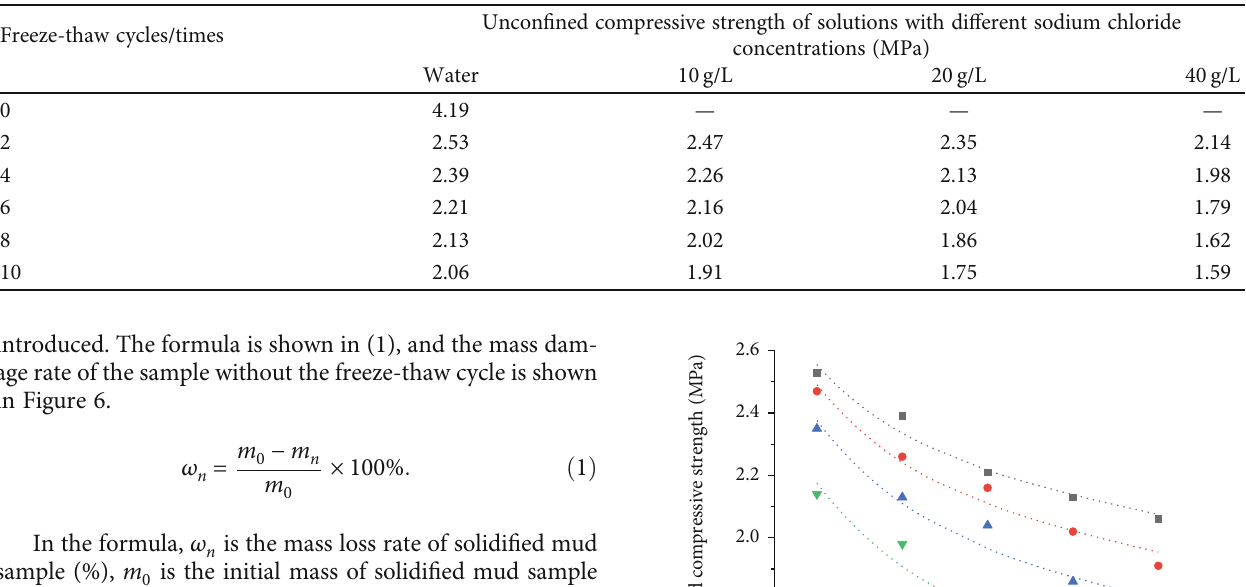
Table 3: Uncon fi ned compressive strength of the